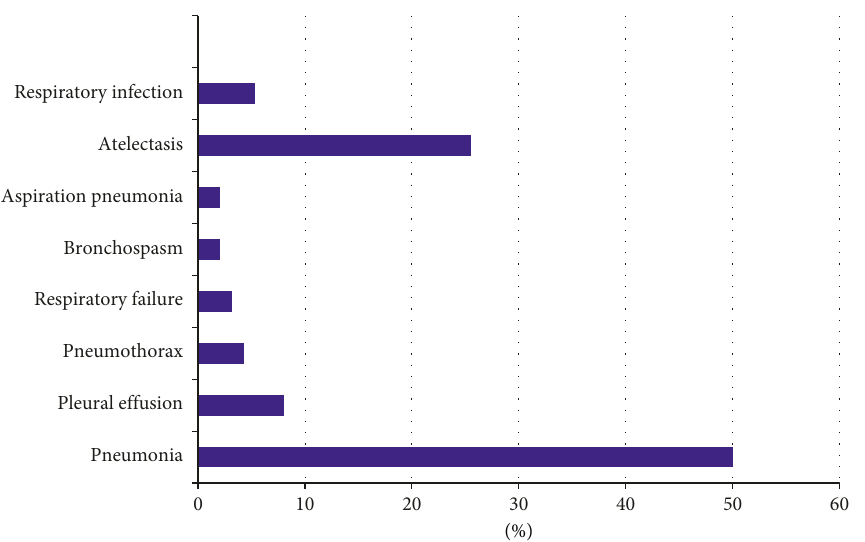
Figure 2: The distribution of postoperative pulmonary complications among patients who underwent abdominal surgery at public hospitals,